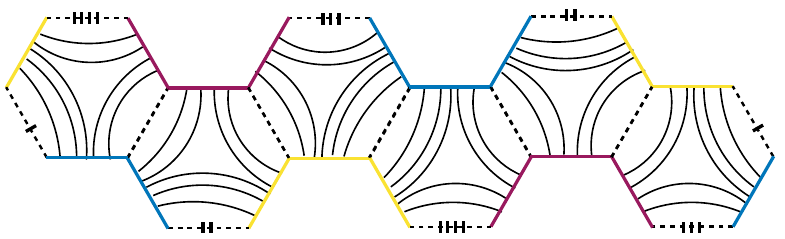
Figure 12 . Using the flow from figure 2 we can create a constructed flow on P which saturates on b p P .